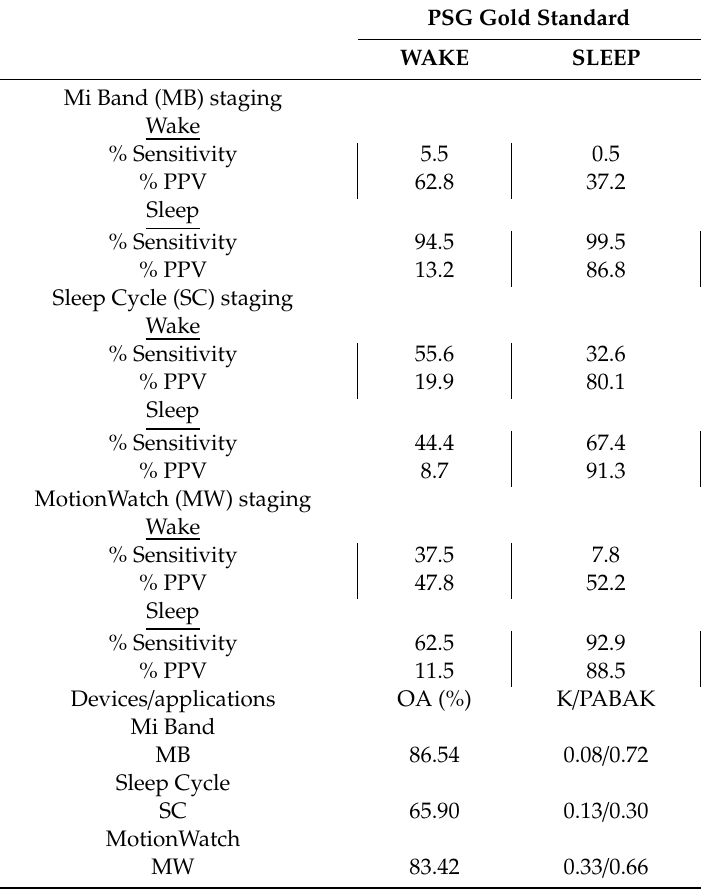
Table 2. Percentages of agreement for 3 stages of sleep scoring (awake / asleep) between the gold standard (PSG) and the scoring of MB and